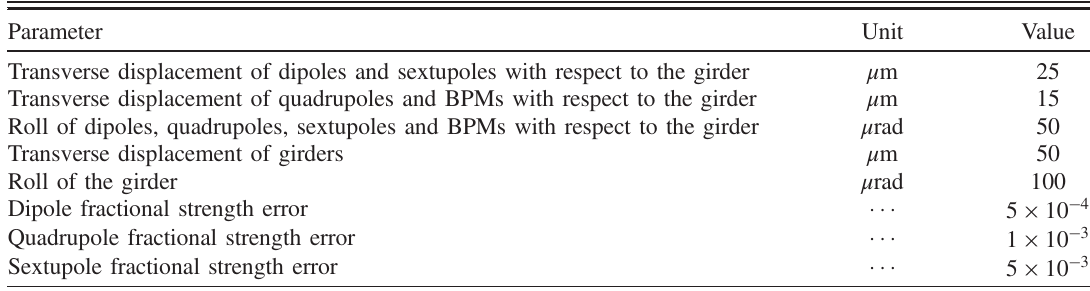
TABLE III. The utilized errors for the COD calculation. The errors have been cut off at 2 sigma. Parameter Unit Value Transverse displacement of dipoles and sextupoles with respect to the girder μ m 25 Transverse displacement of quadrupoles and BPMs with respect to the girder μ m 15 Roll of dipoles, quadrupoles, sextupoles and BPMs with respect to the girder μ rad Transverse displacement of girders μ m Roll of the girder μ rad Dipole fractional strength error Quadrupole fractional strength error